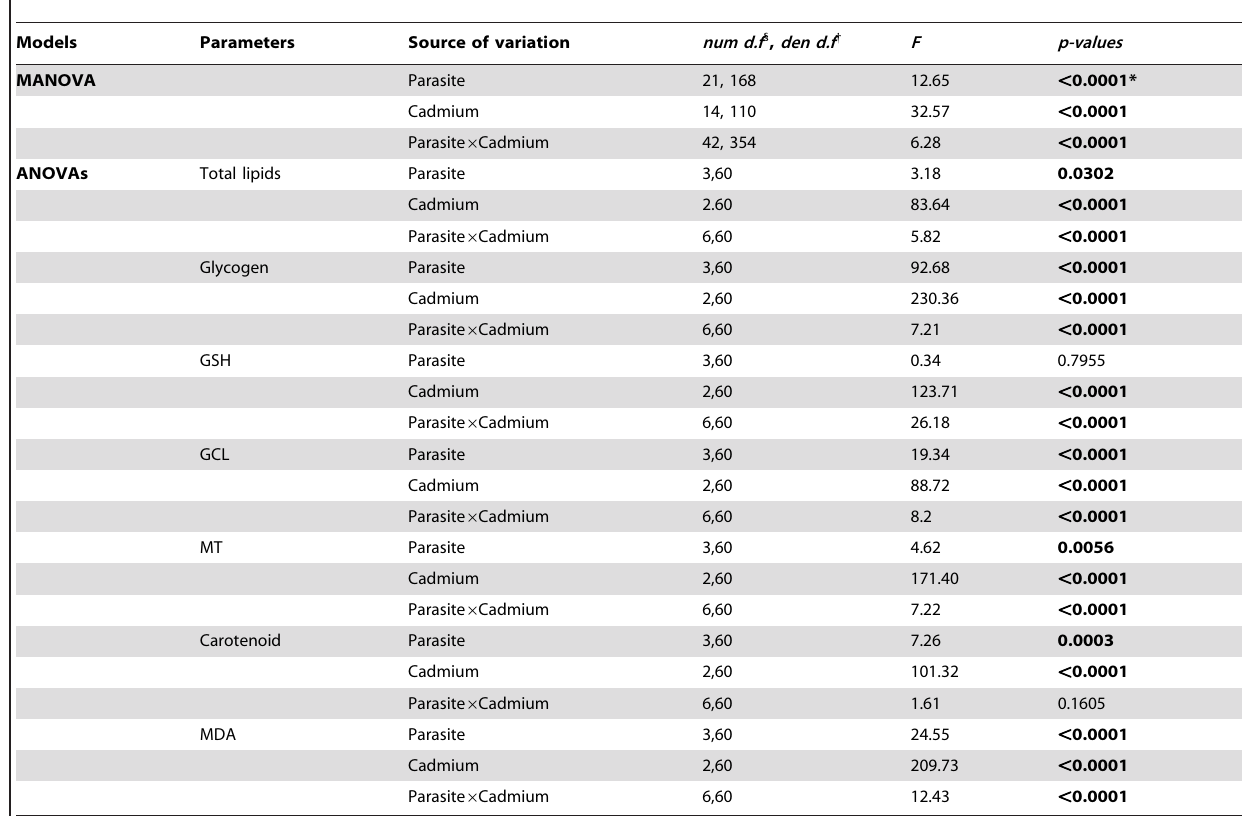
Table 1. MANOVA and ANOVAs for the effects of parasite and cadmium on biomarkers.